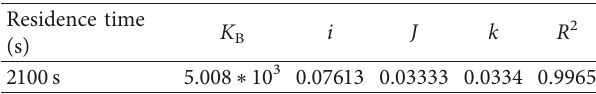
Figure 14: Relationship between crystal breakage propensity and nucleation rate. Table 3: The parameters of the nucleation rate for Botsaries model.